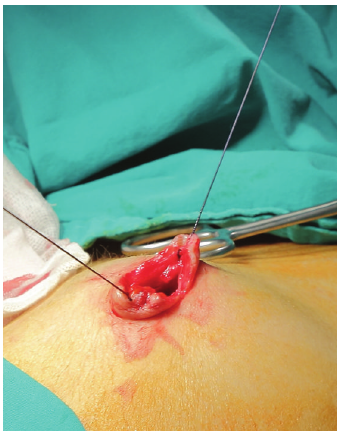
Figure 1: For lifting the entry side, the facial layer of the 1–1.5 cm midumbilical transverse incision was sutured with a number 0 delayed-absorbable suture from the lower and upper border of the incision at 6 and 12 o’clock positions,